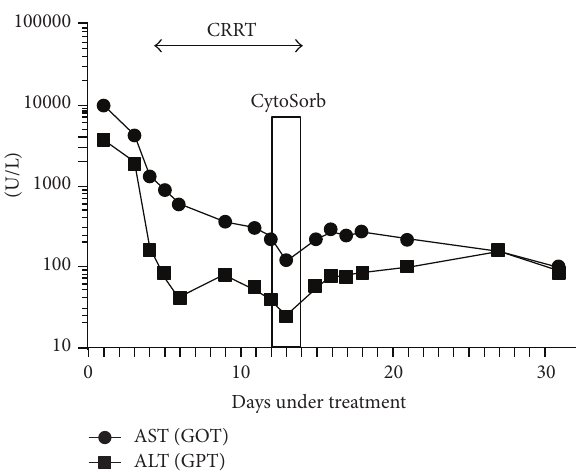
Figure 2: Level of aminotransferases 48 hours before, during, and 48 hours after CytoSorb.